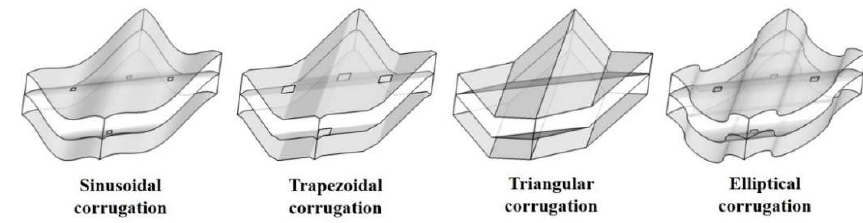
Figure 3. Corrugation configurations used in the present study.